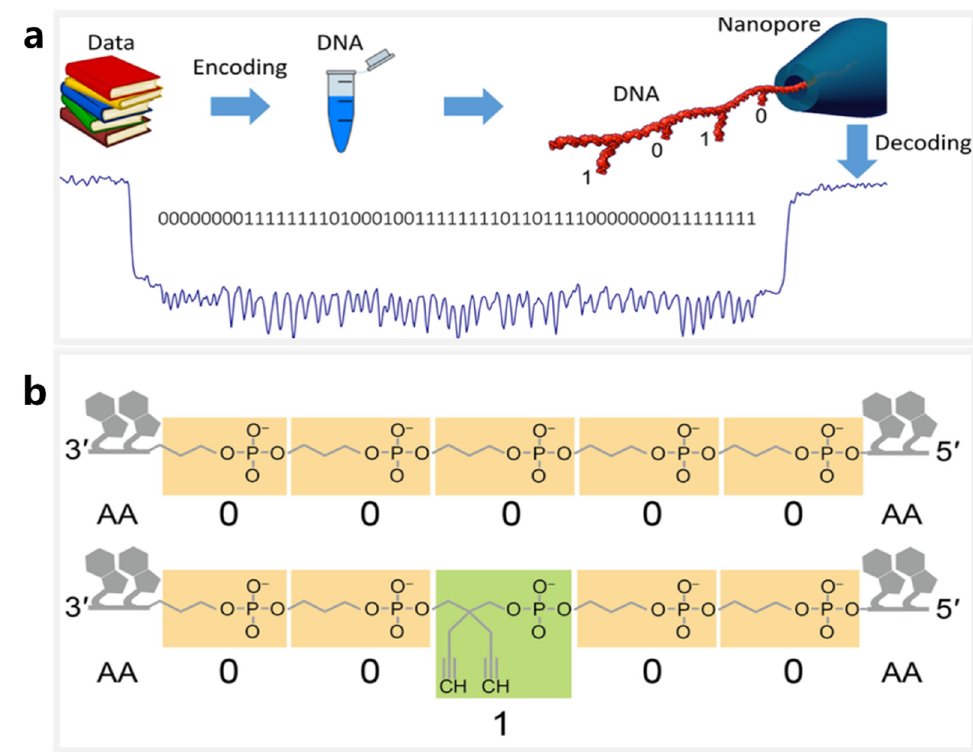
Figure 3. Molecular storage systems based on DNA nanostructures. ( a ) A schematic of the measurement of a DNA carrier using a nanopore, where bits ‘1’ and ‘0’ represent DNA hairpin structures of 16 bp and 8 bp, respectively. Reproduced with permission from Kaikai Chen, Nano Letters; American Chemical Society, 2019. ( b ) An illustration of biopolymer sequences, where ‘0’ represents a monomer molecule and ‘1’ represents its methylated version. Reprinted from [106].